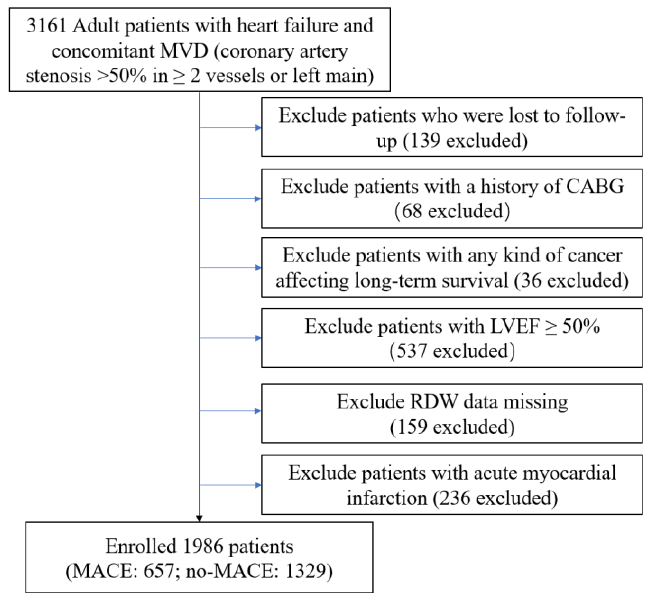
Figure 1. Flow chart of study population. Abbreviations: MVD: multivessel disease; CABG: coronary artery bypass grafting; LVEF: left ventricular ejection fraction; RDW: red blood cell distribution width; MACE: major adverse cardiovascular